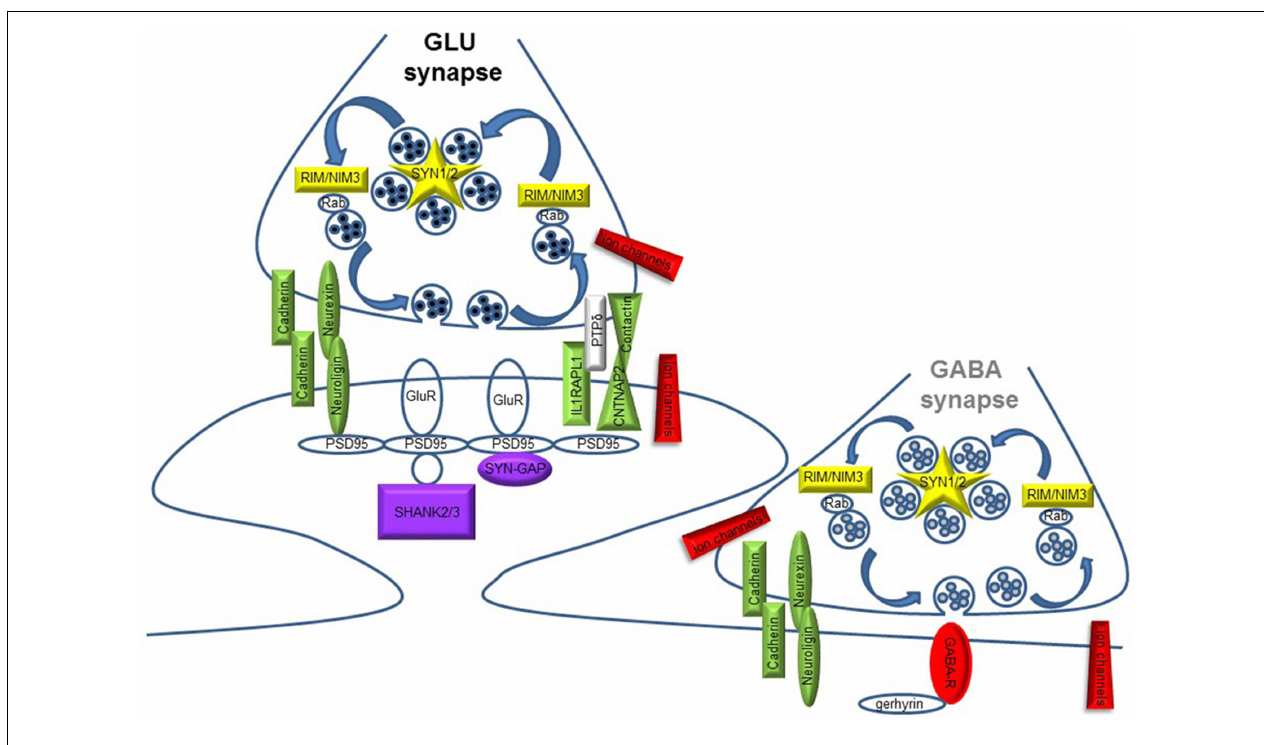
cycling; green, synapse formation and maintenance; red, neuronal excitability and neurotransmission; violet, glutamate receptors (GluR)